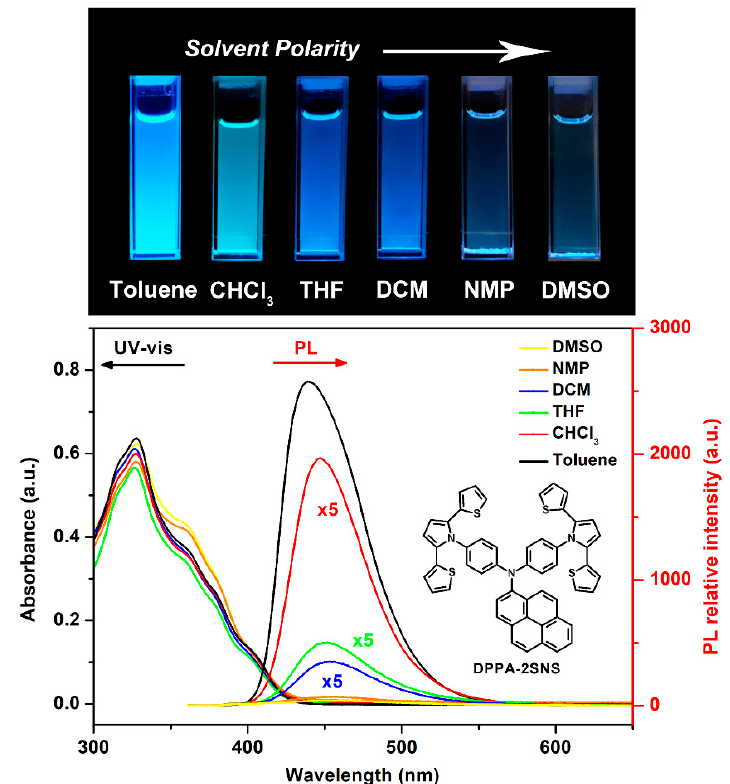
Figure 1. PL images, UV-vis absorption, and PL profiles of the dilute solutions (ca. 1 × 10 − 5 M) of DPPA-2SNS in various solvents. Photographs were taken under illumination of 365 nm UV light.